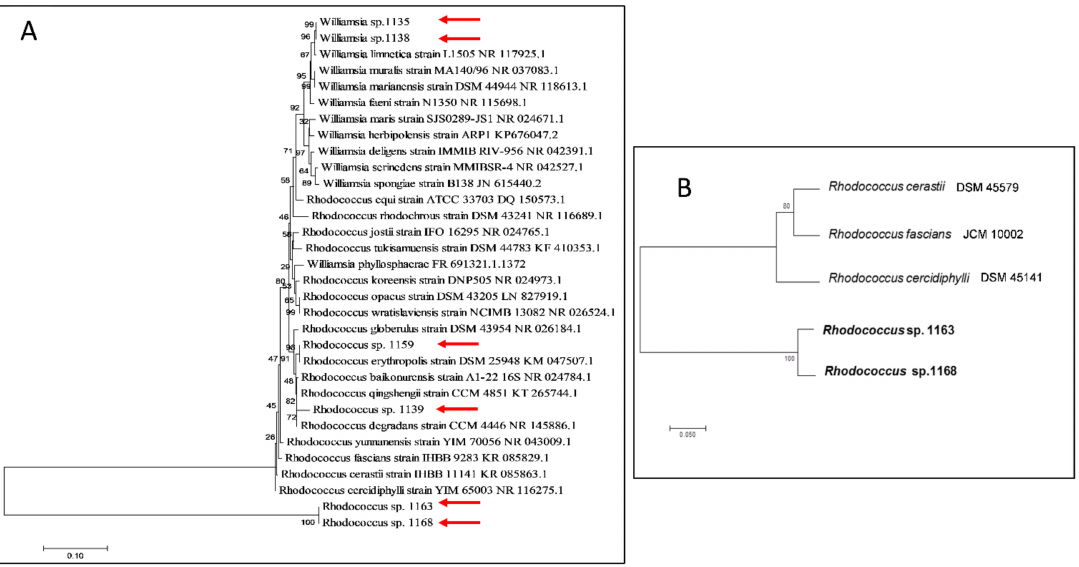
Figure 3. Neighbour-joining phylogenetic trees based on ( A ) BLAST analysis of 16S rRNA gene sequences obtained by PCR amplification of DNA extracted from six sub-Antarctic strains and ( B ) alkane 1-monooxygenase gene ( alkB ) gene sequences from whole genome sequences of Williamsia spp. 1135 and 1138 and Rhodococcus spp. 1139, 1159, 1163 and 1168. Bootstrap values shown at branch nodes were based on 1000 re-samplings and the alkB gene sequences in ( B ) are from published genomes of the type strains for the species selected. The sub-Antarctic strains are marked with a red arrow in panel ( A